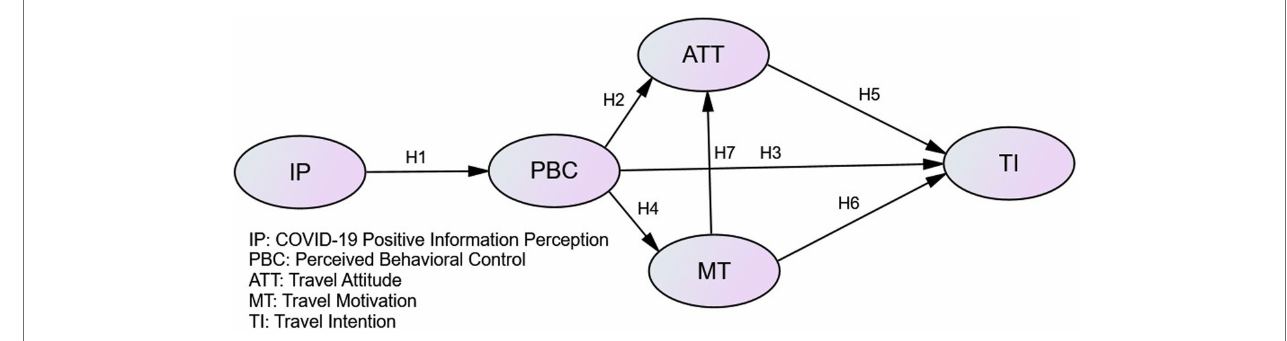
FIGURE 1 | Conceptual model.